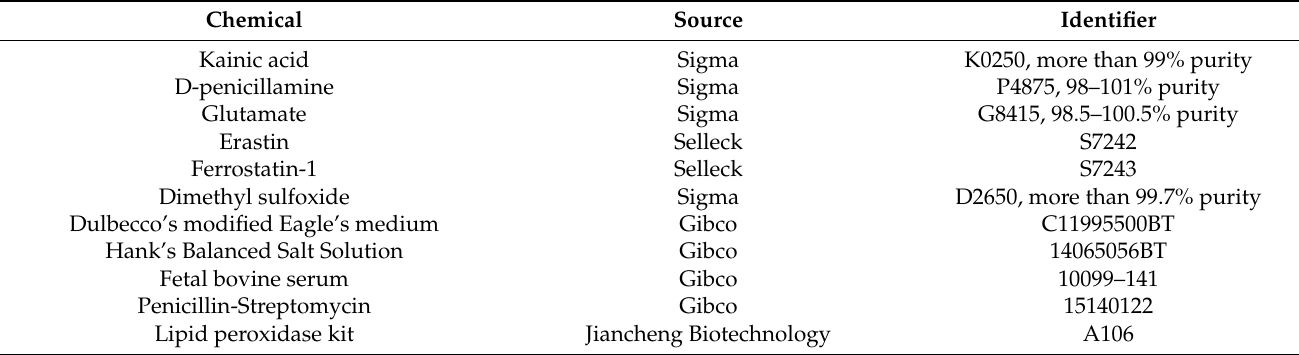
Table 1. Chemicals used in our present